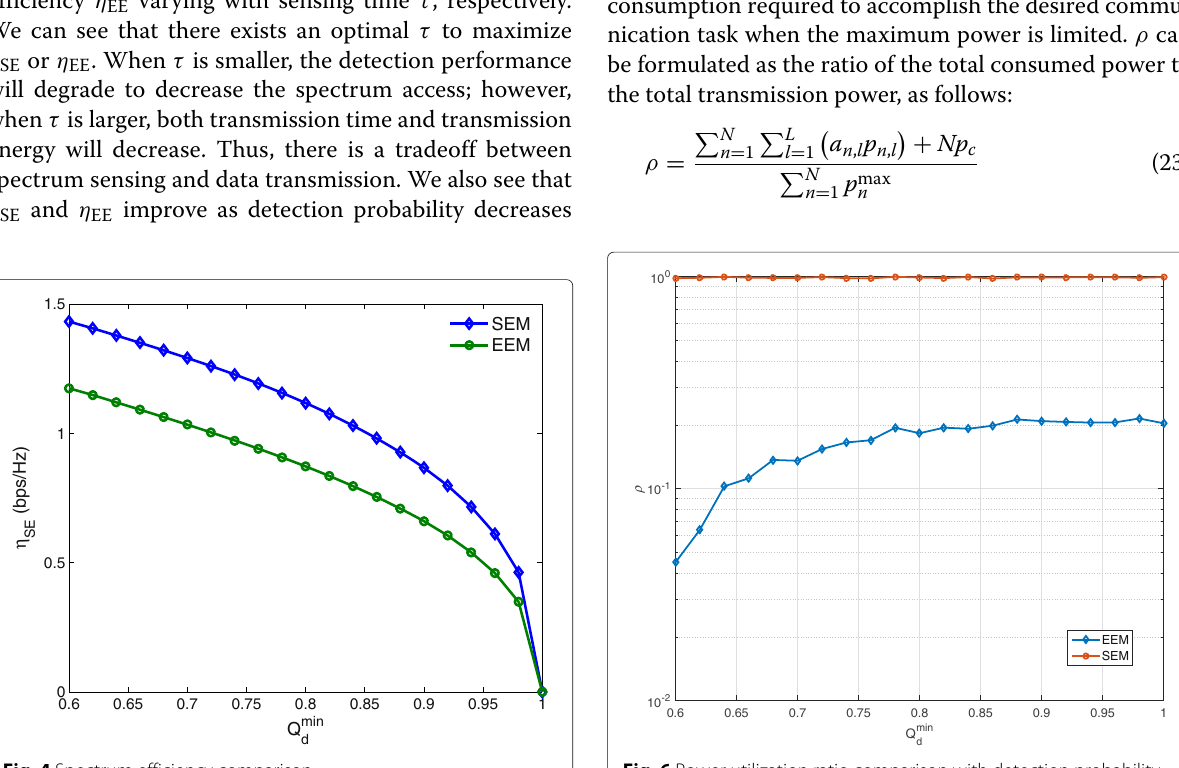
Rayleigh distribution with the mean − 10 dB, the absence probability of the PU is P r (θ l = 0 ) = 0.5, the frame duration is T = 100 ms, the length of cooperative inter- action slot is ε = 1 ms, the sampling frequency is f s = 100 KHz, the maximal power of each SU is p max the sensing power p c = 1 mW, and the noise power is = 0.01 mW. σ 2 l Figures 2 and 3 show spectrum efficiency η SE and energy